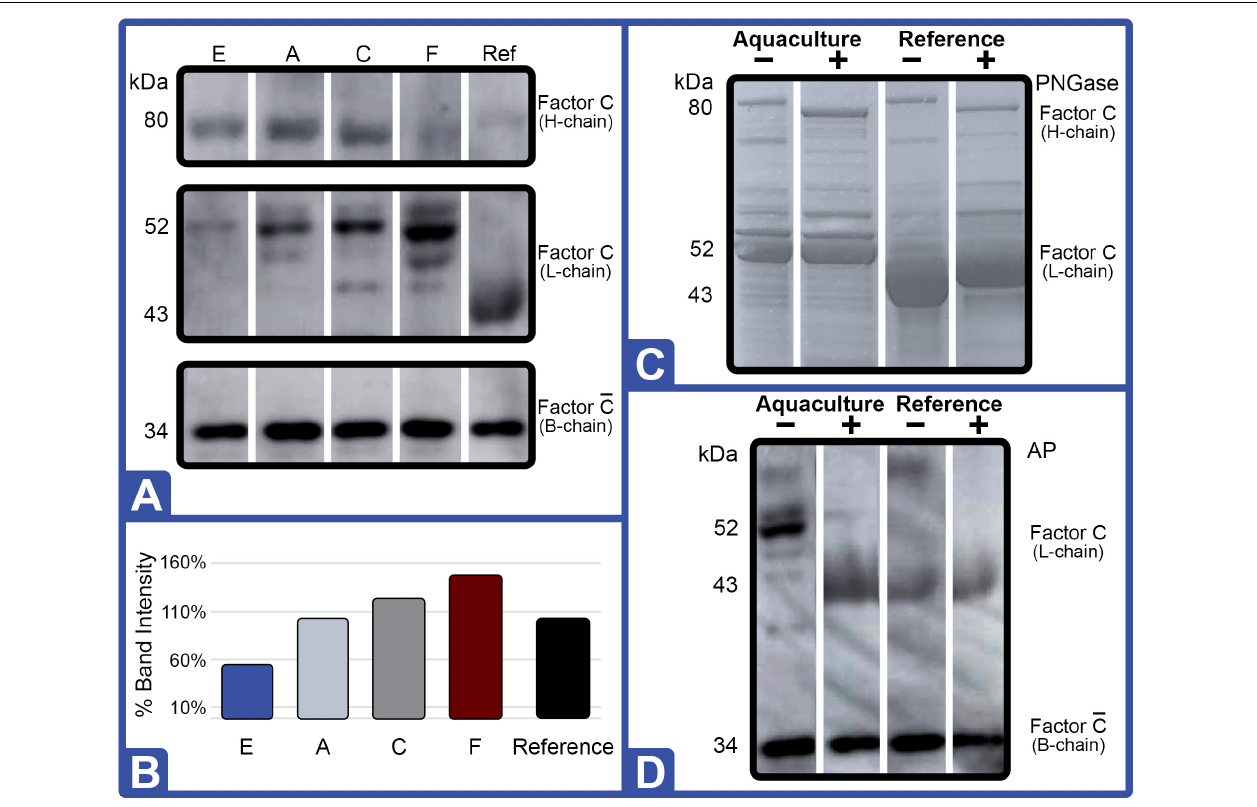
FIGURE 6 | Effect of diet on Factor C protein expression (Feed Study 3). (A) Western blot of crude lysates (5 µ g) of LAL from each diet vs. reference LAL. Extracts from Diet E (Lane 1), Diet A (Lane 2), Diet C (Lane 3), Diet F (Lane 4), and reference LAL (Ref; Lane 5) with See Blue+2 molecular weight marker. Each sample was resolved across 8.0% Tris-Glycine gel and transferred to PVDF membrane. Proteins analyzed by membrane incubation with anti-Factor C polyclonal rabbit antibodies (COCH). (B) Total Factor C protein abundance (% band intensity) quantified on an imaging device. Zymogen and activated Factor C were